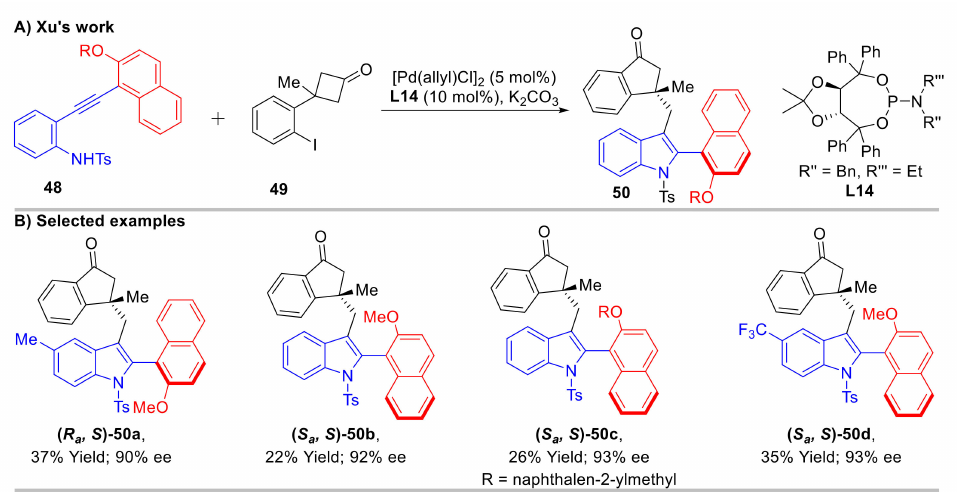
Scheme 14. Asymmetric synthesis of